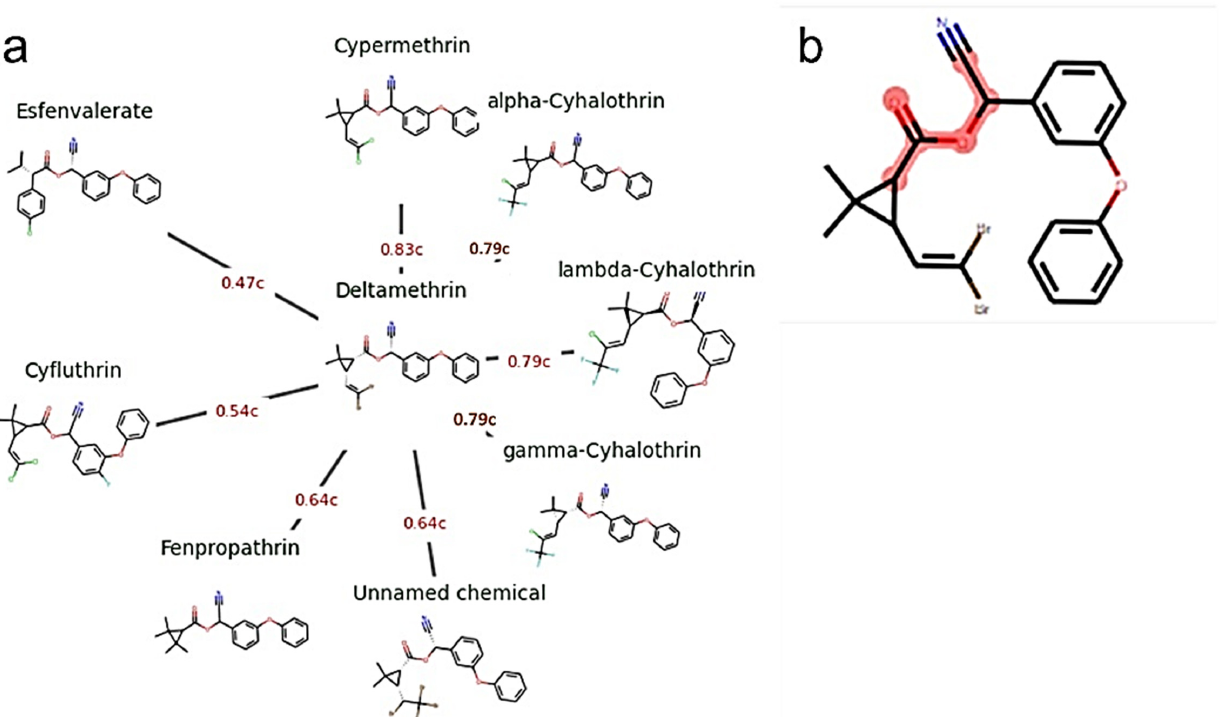
Figure 6. The equivalents to deltamethrin based on the Morgan fingerprints, ( a ) displays the eight closest analogues of deltamethrin. The analogues are shown in a clockwise manner and in declining order of Jaccard similarity, which is indicated by a red highlight (as decimal numbers followed by ‘c’). Where unnamed, chemical (chemical without trade name) = (S)-Cyano(3-phenoxyphenyl) methyl (1R,3S)-2,2-dimethyl-3-(1,2,2,2-tetrabromoethyl) cyclopropane-1-carboxylate. ( b ) Common substructure denoted highlighted in red shade.